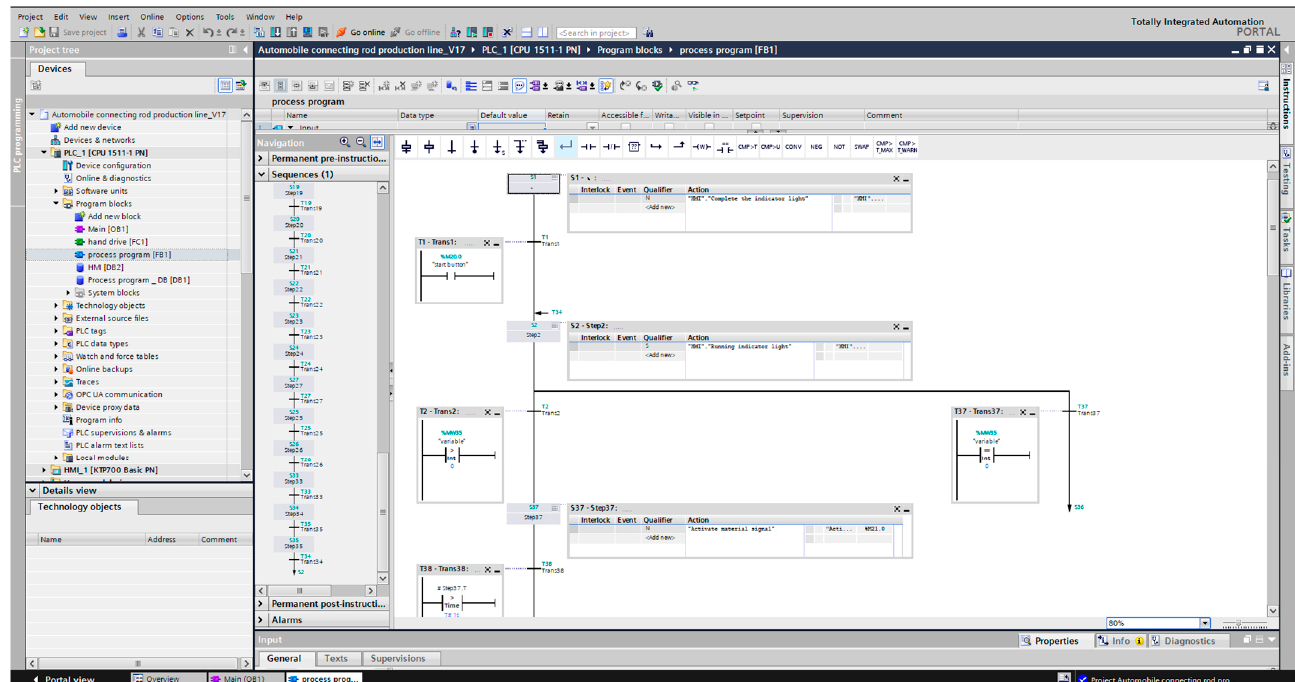
Figure 11. The reset program.